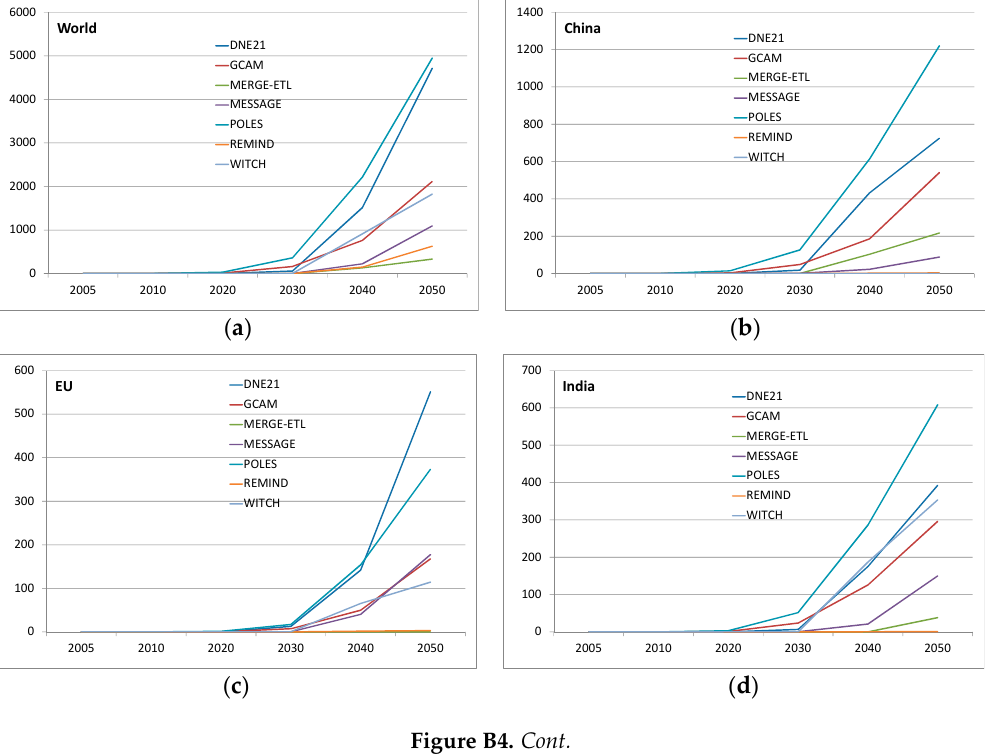
( e ) Figure B4. Inter-model comparison of installed capacity (GW) for coal and gas CC in ( a ) World (2030– 2050 growth rate = 7%–17% p.a.); ( b ) China (2030–2050 growth rate = 0–15% p.a.); ( c ) The EU (2030– 2050 growth rate = 6%–15% p.a.); ( d ) India (2030–2050 growth rate = 6%–22% p.a.) and ( e ) USA (2030– 2050 growth rate = 6%–18% p.a.). 9.